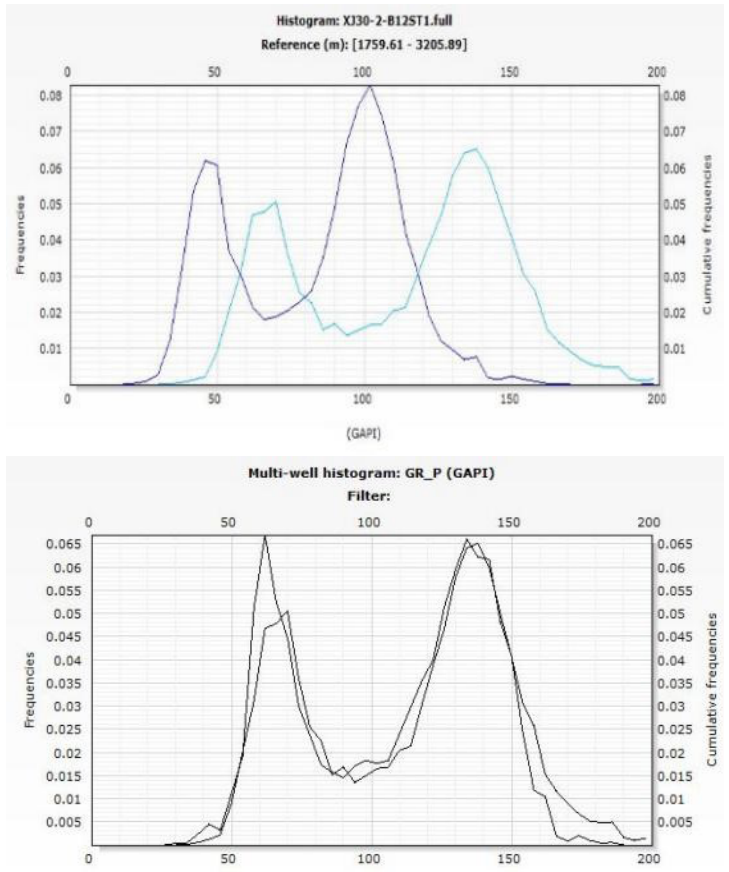
Fig. 7 GR frequency histogram before and after normalisation by mean square error method.